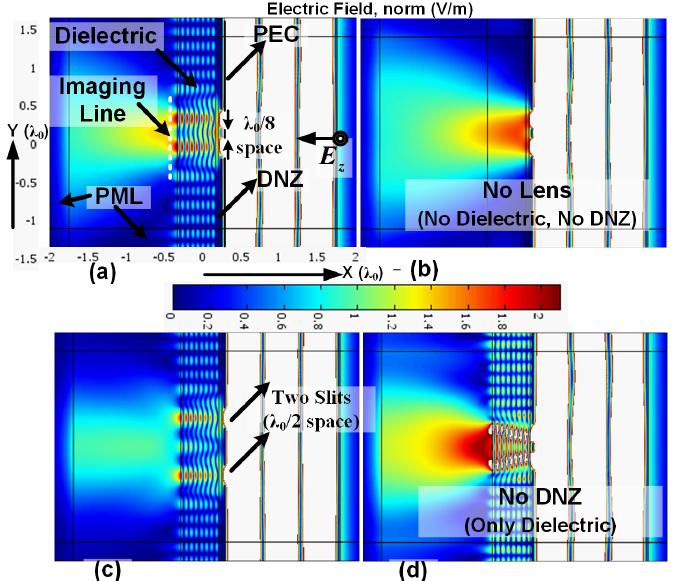
Figure 3. Projection of two PEC slits: ( a ) with the proposed two-layer slab—space between two slits: λ 0 /8; ( b ) without the two-layer slab; ( c ) with the two-layer slab—space between two slits: λ 0 /2; ( d ) only with the dielectric layer and without the DNZ layer—space between two slits: λ 0 /8. The image line is a white dotted line shown on the left side of the dielectric layer in Figure 3a. As shown, the projection of the two slits on the image line is clear and distinc- tive. Figure 3b shows the field distribution without the presence of the two-layer slab. Without the two-layer slab, there is no clear image of the slits on the image line due to the